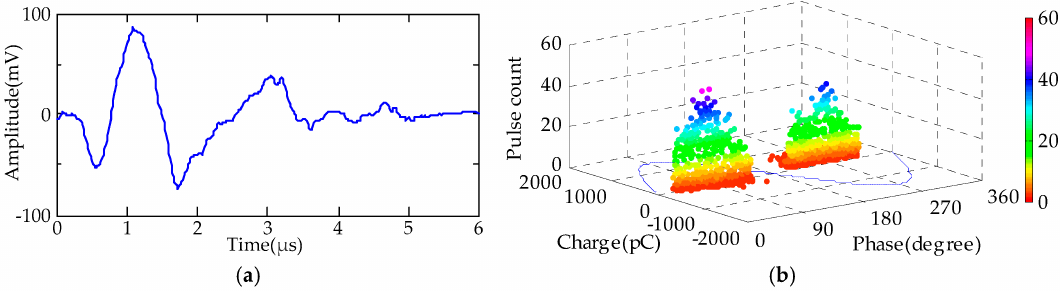
Figure 6. Data ( a ) waveform, ( b ) PRPD pattern [13].